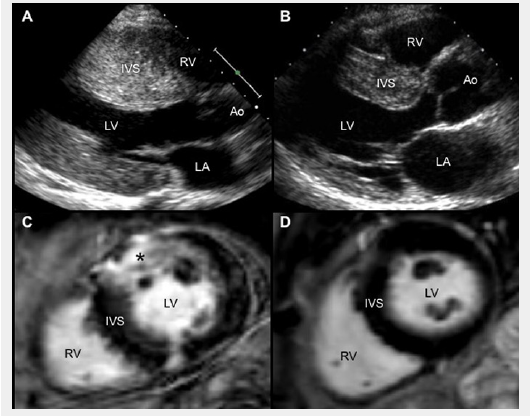
(A) Patient in NYHA functional class II with nonobstructive HCM and a maximal wall thickness of 35 mm and elevated hs-cTnT level (0.05 ng/ml). (B) Patient with obstructive HCM controlled with beta blocker therapy, a maximal wall thickness of 19 mm and normal hs- cTnT level. (C) Patient with nonobstructive HCM and a maximal wall thickness of 22 mm. On CMR, patient shows extensive LGE (17% of LV mass) in the anterior wall segments (*) along with an elevated hs-cTnT level (0.031 ng/ml). (D) Patient with nonobstructive HCM and a maximal wall thickness of 16 mm without LGE on CMR and normal hs-cTnT level. Ao = Aorta; CMR = cardiovascular magnetic resonance; HCM = hypertrophic cardiomyopathy; hs-cTnT = high-sensitive cardiac troponin T; IVS = interventricular septum; LA = left atrium; LGE = late gadolinium enhancement; LV = left ventricle; NYHA = New York